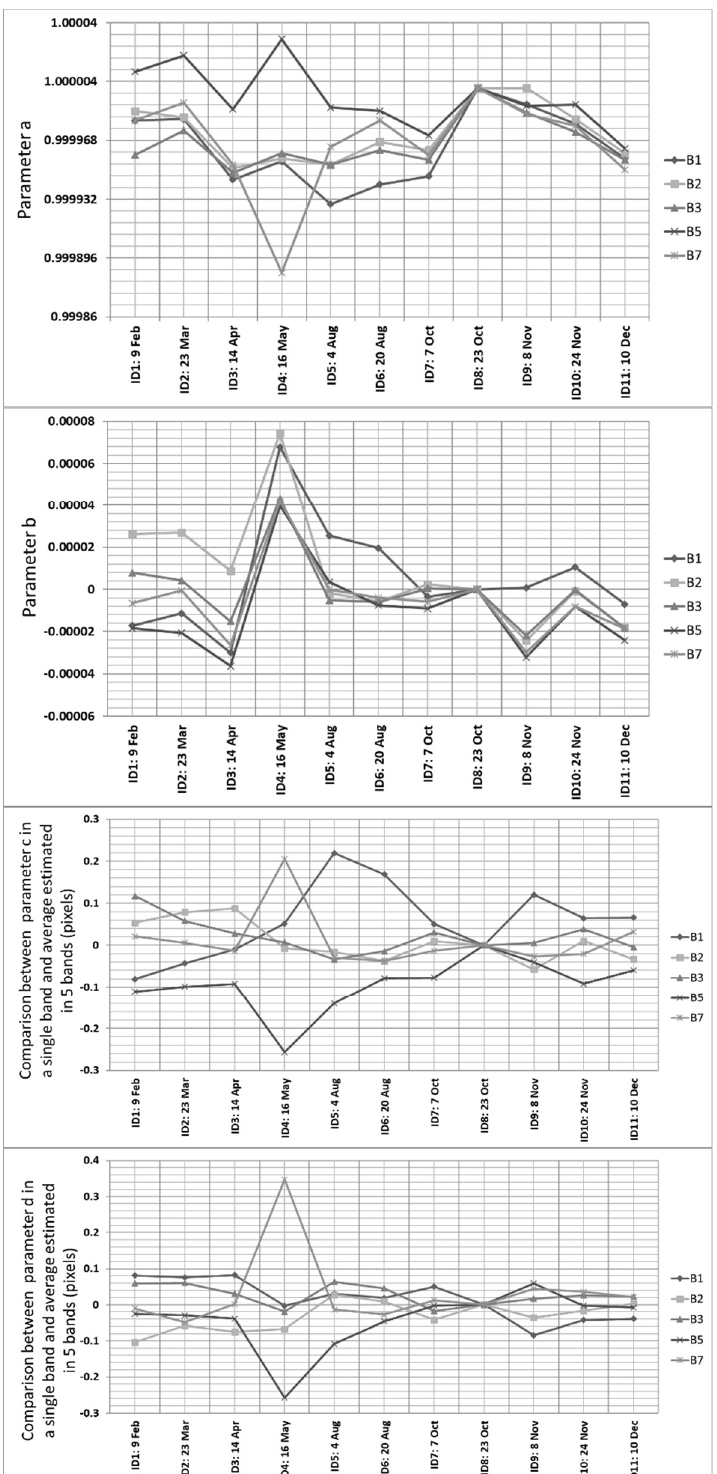
Figure 8. Comparison between the estimated parameters for all the images of ‘Multan’ dataset as obtained from different spectral bands (see legends on the right side of each graph). For parameters a and b the values obtained from three different experiments are displayed, while for parameters c and d (shifts) the differences with respect to the average estimated values are shown.